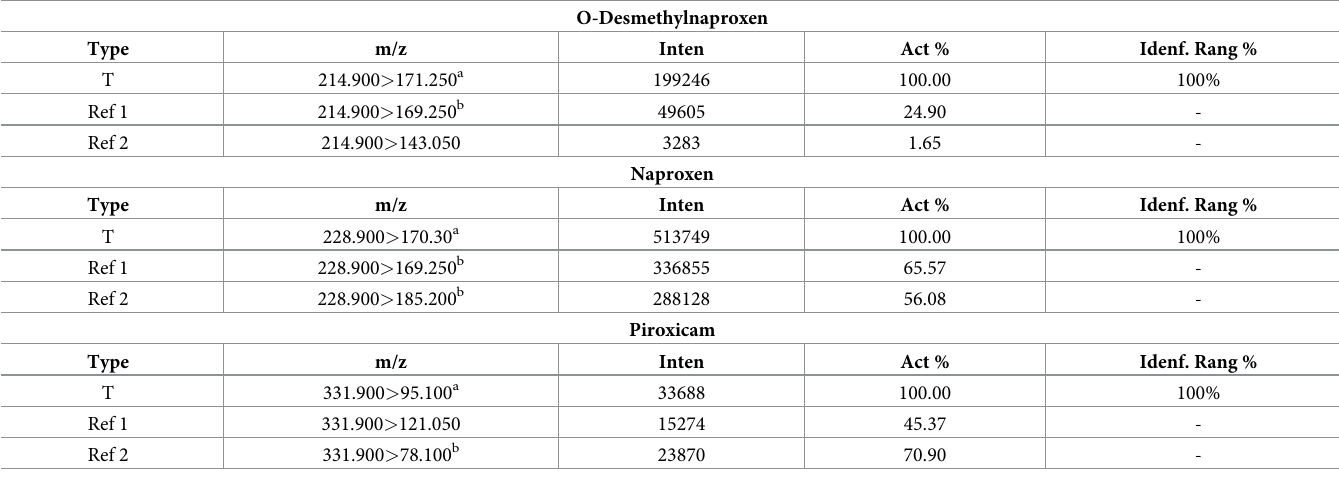
Table 1. Quantifier and qualifier product ions used in the